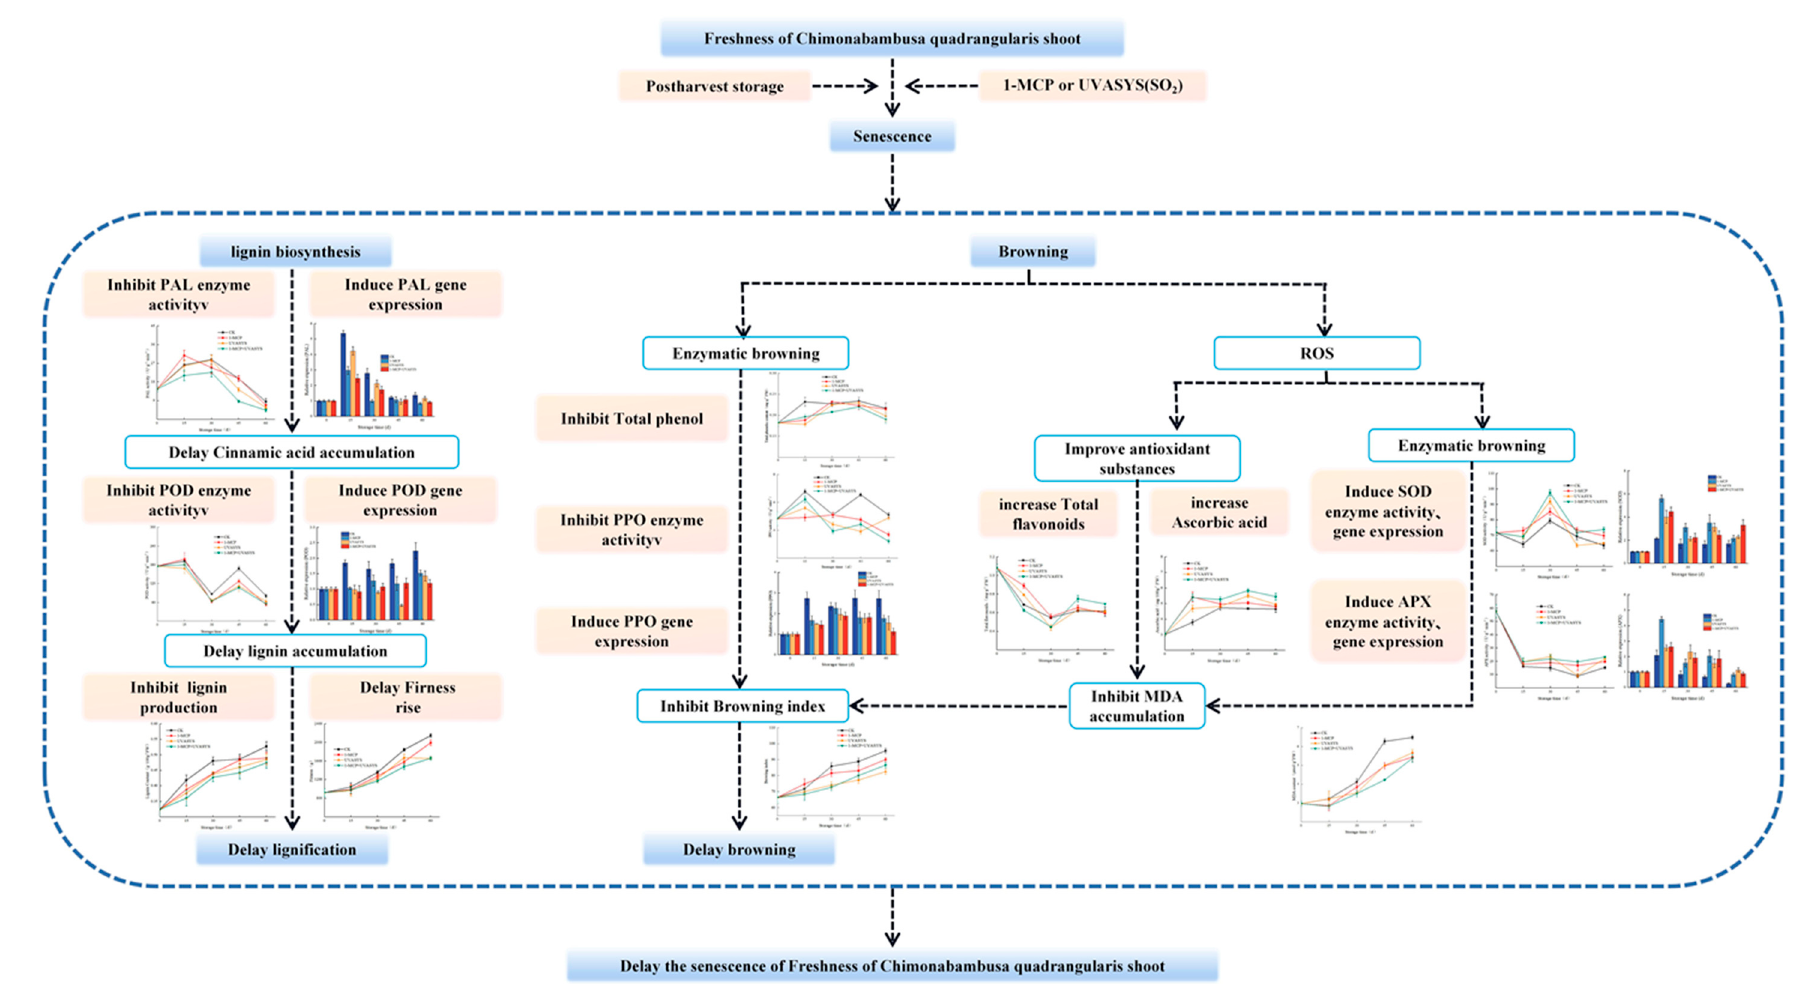
Figure 9. 1-MCP and UVASYS treatment delayed the senescence of Freshness of Chimonabambusa quadrangularis shoot after harvest and its molecular regulation mechanism.